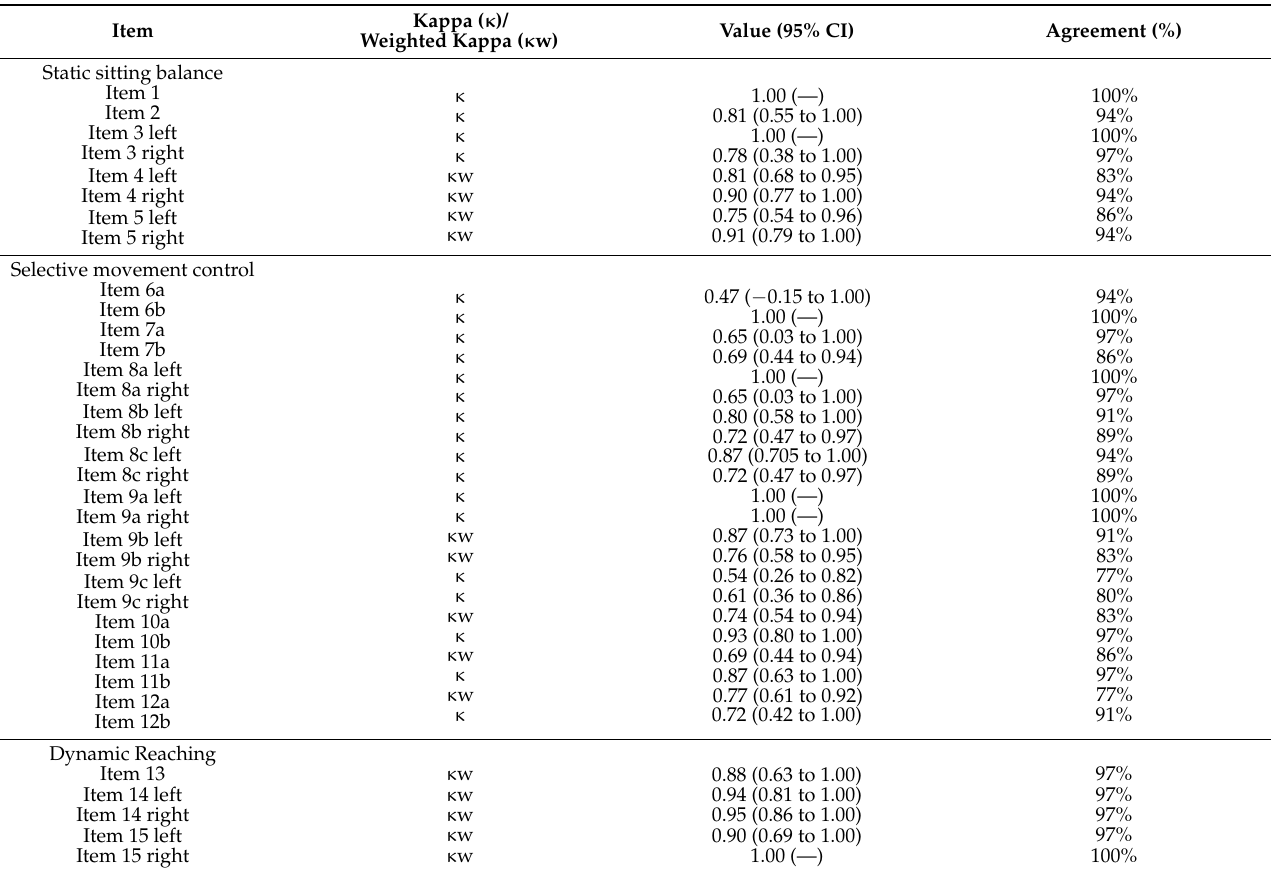
Table 3. Agreement test–retest for each item of the Spanish version of the Trunk Control Measurement